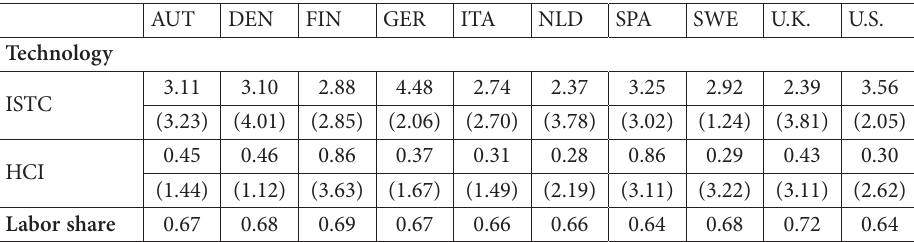
Table 2. Average Annual Growth Rates, 1980–2010